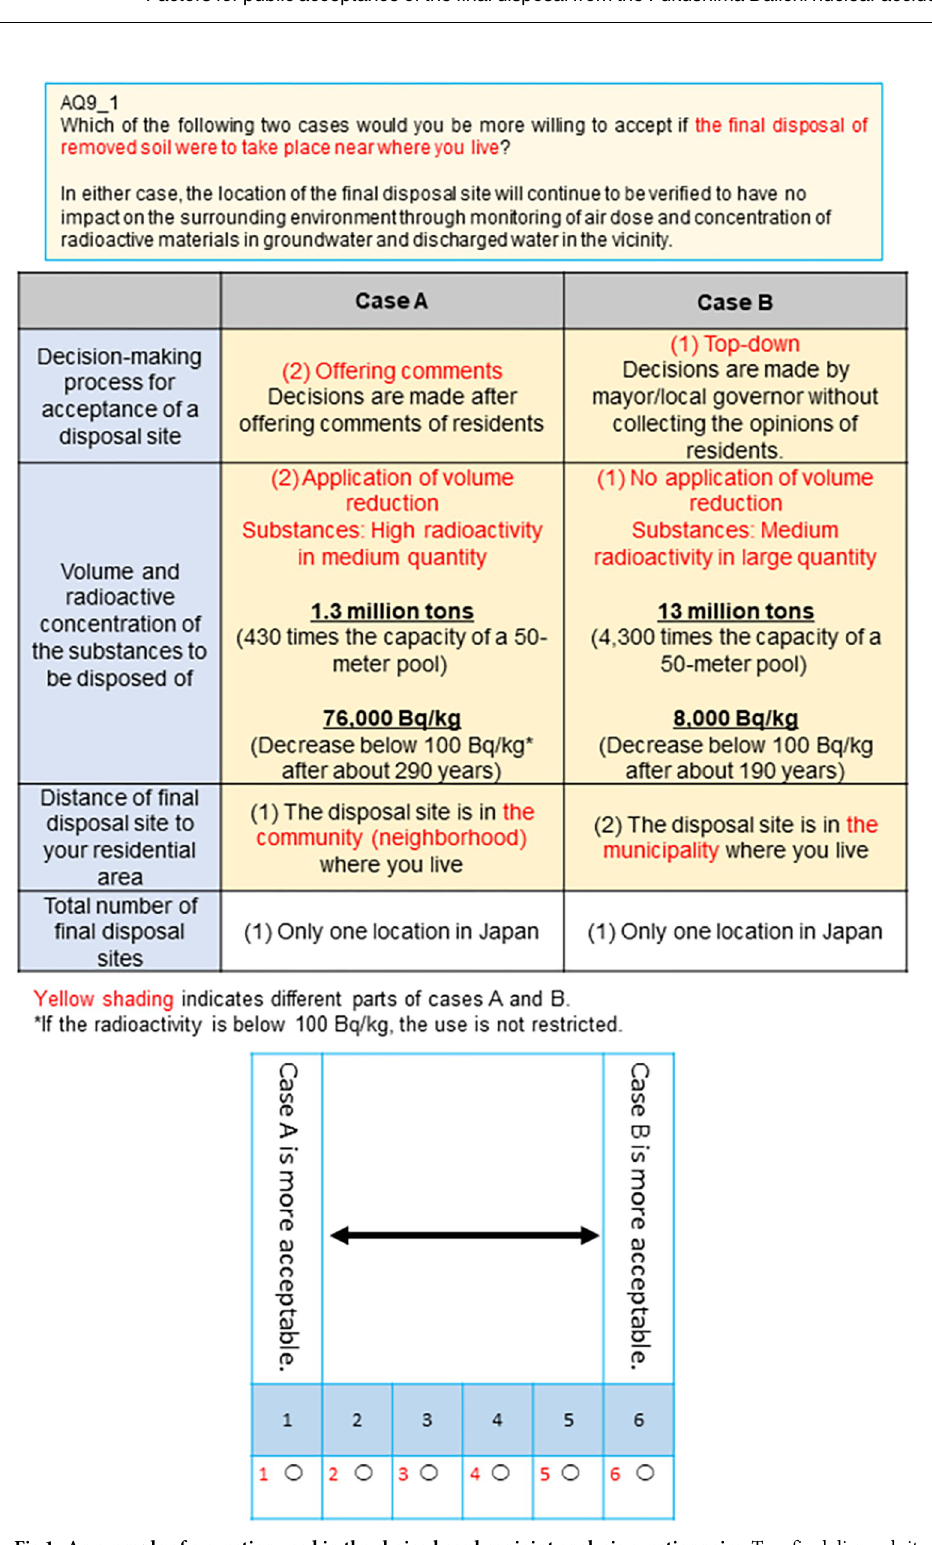
Fig 1. An example of a question used in the choice-based conjoint analysis questionnaire. Two final disposal site scenarios (profiles) were presented in each selection screen. The levels of the attributes were different in each selection screen. The questionnaire was in Japanese, and was translated into English for this